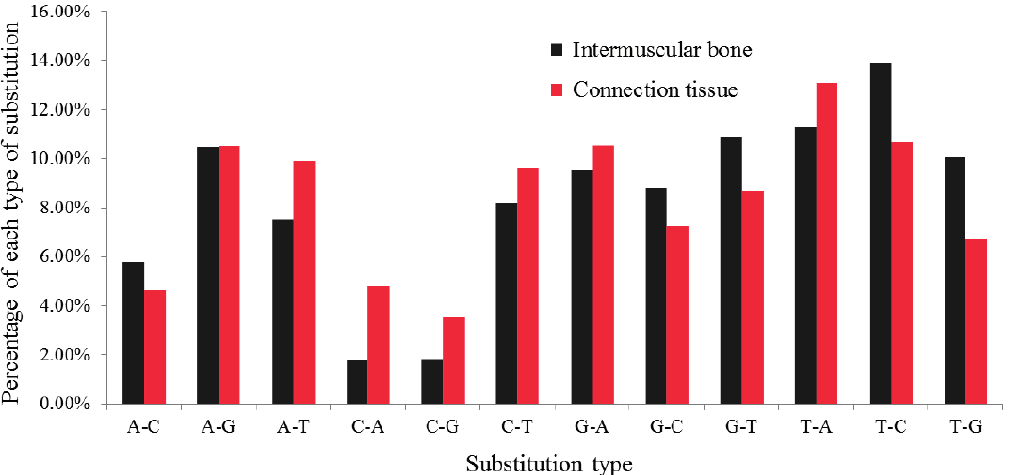
Figure 3. Histogram displaying the single nucleotide substitutions in the miRNAs seed region sequence when aligning un-annotated sRNAs tags with mature miRNAs from miRBase20.0. The x -axis represents the substitution type from genome to RNA (small RNA sequence). The y -axis represents the percentage comparing of the observed count of each type to the total count of all substitution